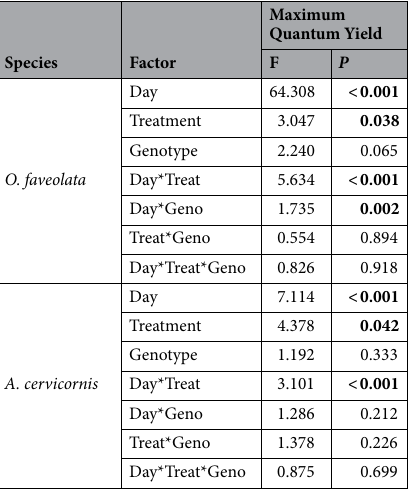
Table 3. Results of linear mixed effects models evaluating the effect of fixed factors day, treatment, and genotype on maximum quantum yield (F v /F m ). Significance at P < 0.05 is noted in